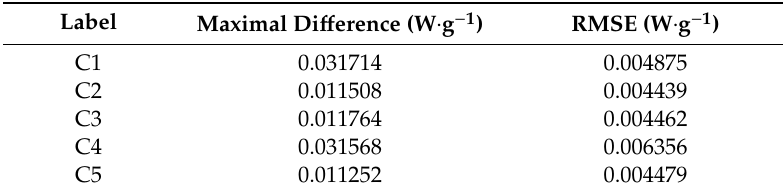
Table 4. Evaluation of agreement of DSC curves obtained using experimental measurement and computational modeling.